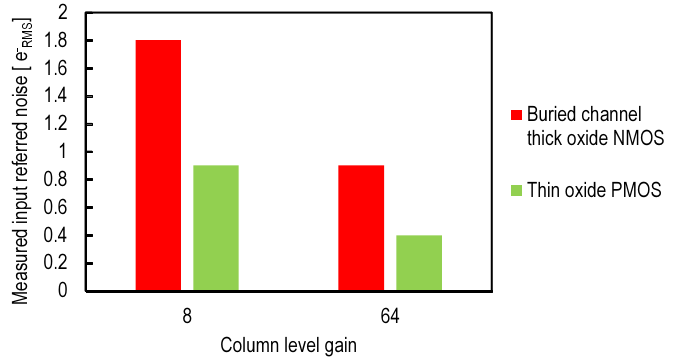
Figure 13. The measured input-referred total noise of a CIS readout chain, with 4T pixel and column amplification, for two column level gains A col , for an in-pixel buried channel thick oxide NMOS source follower and a thin oxide PMOS source follower from [8].